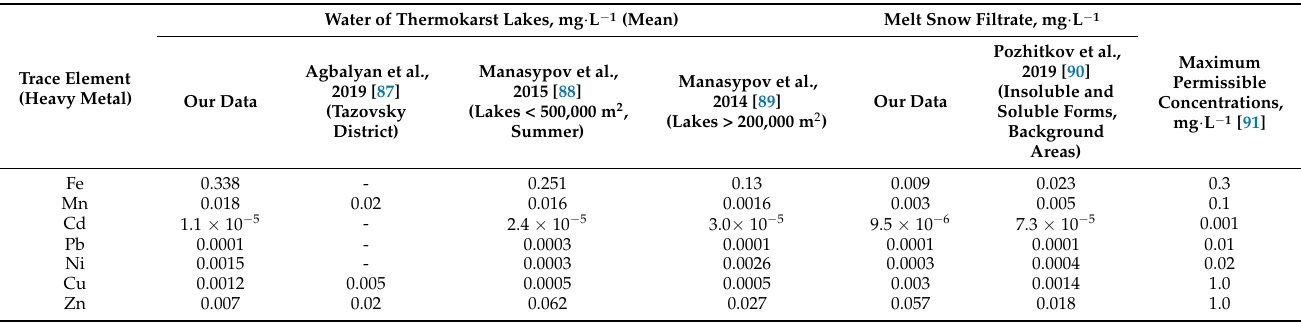
Table 2. Concentrations of heavy metals in snow melt and thermokarst lake waters of the Tazovsky District of the YNAO compared with permissible